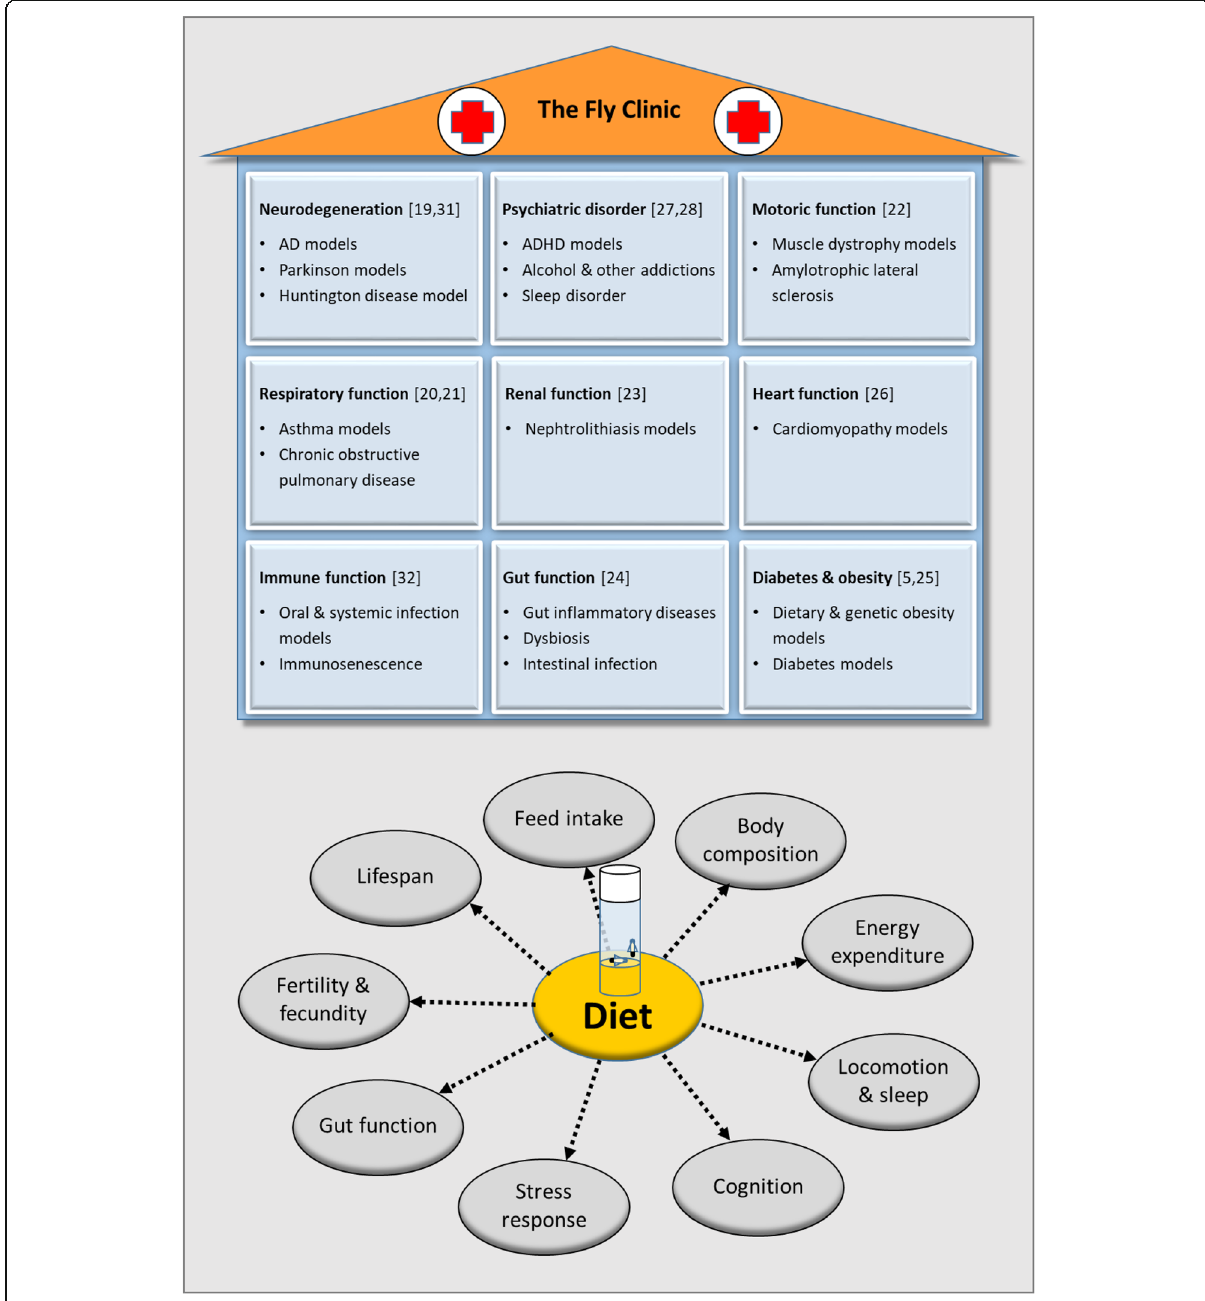
Fig. 1 The fly clinic. Comprehensive phenotyping in Drosophila melanogaster forms the foundation of the fly clinic, where disease-related Drosophila models are employed to study diet-disease interactions [5, 19 – 28, 31,